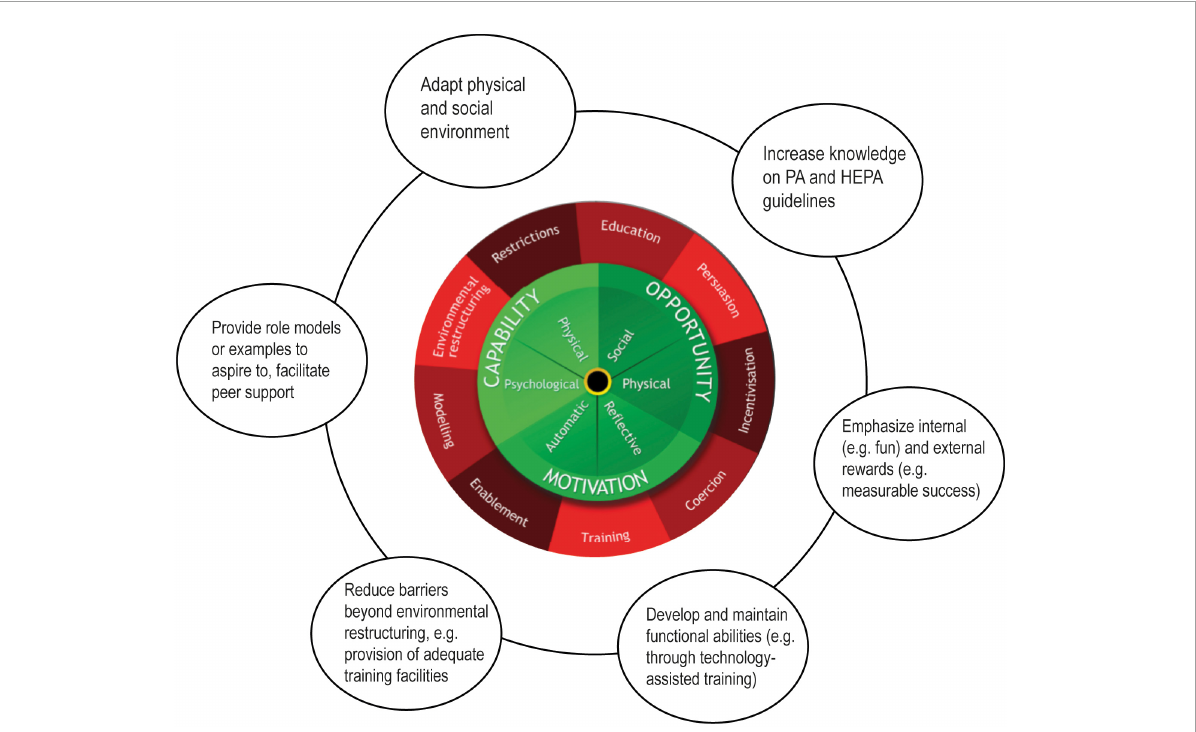
FIGURE2 The behavior change wheel BCW and possible intervention strategies in the context of this study. Figure based on “The behavior change wheel” by Michie et al. (2011) licensed under CC BY 2.0